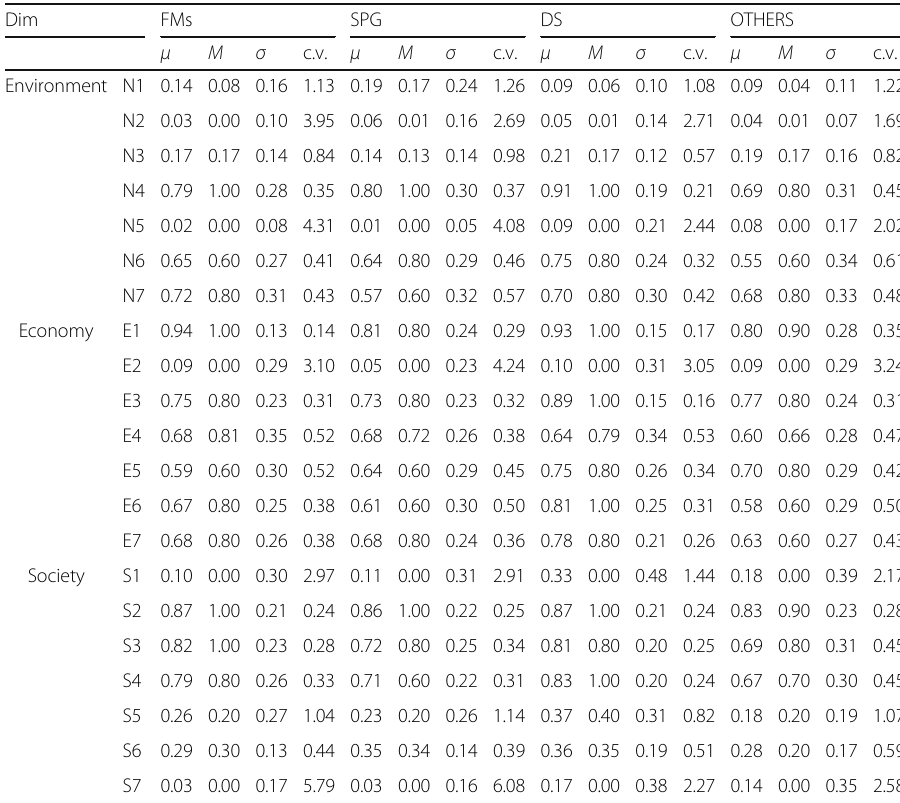
Table 4 Descriptive statistics of indicators by sustainability dimension and market scheme: μ = average, M = median, σ = standard deviation, c.v. = coefficient of